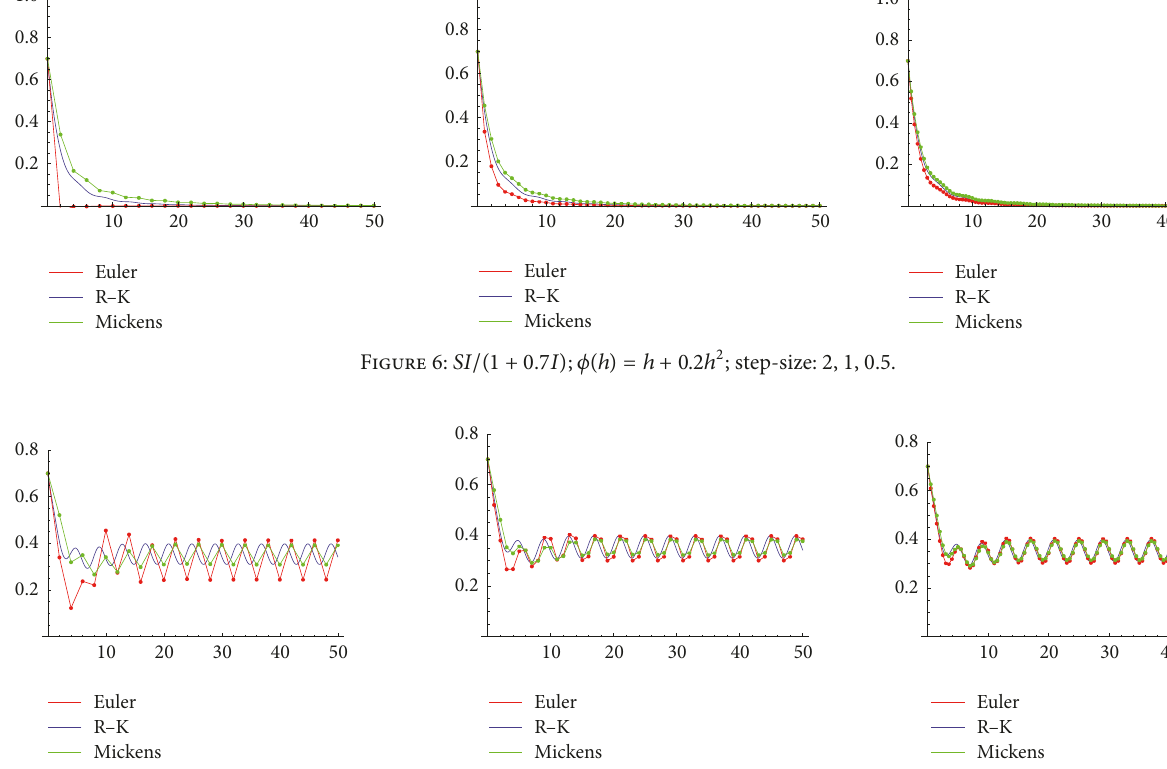
Figure 7: 𝑆𝐼/(1 + 0.7𝐼) ; 𝜙(ℎ) = ℎ + 0.2ℎ 2 ; step-size: 2 , 1 , 0.5 .